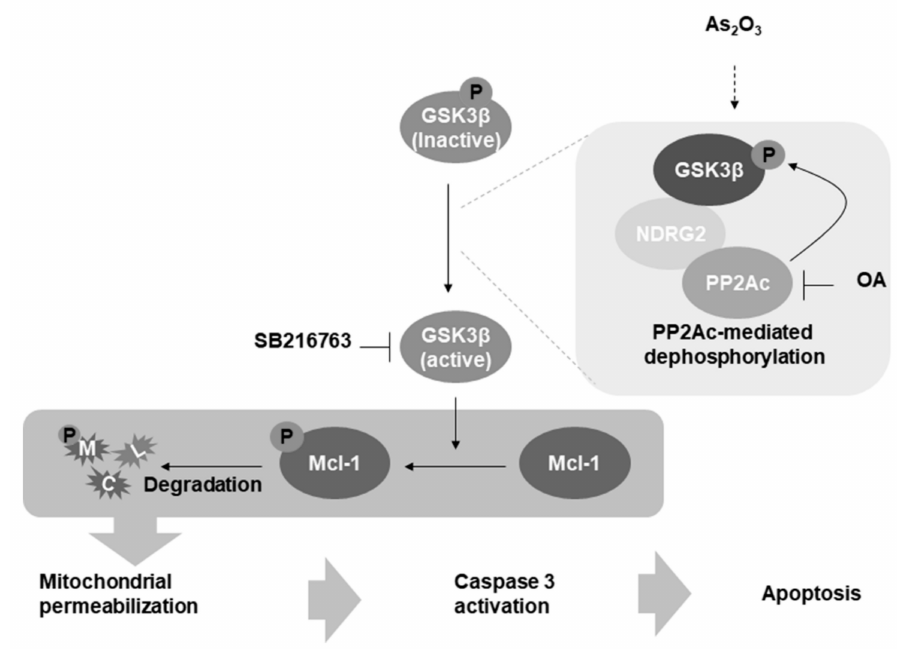
Figure 6. Diagrammatic representation of the proposed apoptotic pathway that mediates the higher sensitivity to As 2 O 3 in NDRG2-expressing U937